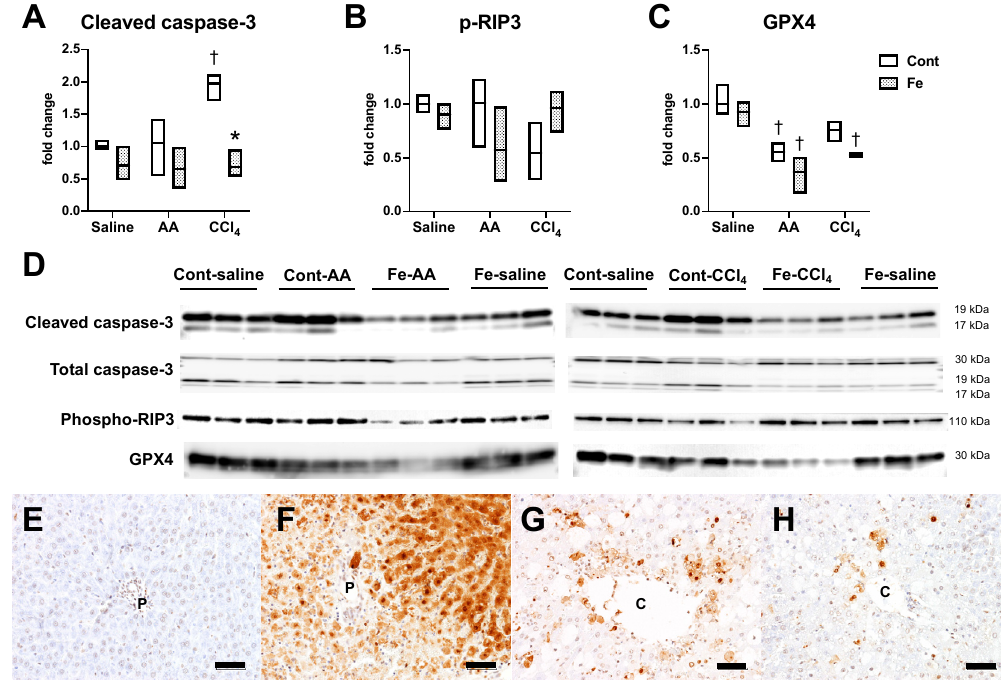
Figure 7. Western blot data for cleaved/total caspase-3 ( A ), phospho-RIP3 ( B ), and GPX4 ( C ). * p < 0.05 vs. control diet group with same chemical administration (diet factor), † p < 0.05 vs. saline group with same diet feeding (chemical factor), by Sidak’s multiple comparison. ( D ) shows the images of the bands analyzed. Representative images of TUNEL assay in the liver of Cont-AA ( E ), Fe-AA ( F ), Cont-CCl 4 ( G ) and Fe-CCl 4 ( H ) groups. P, portal vein; C, central vein. Bar = 50 µm.